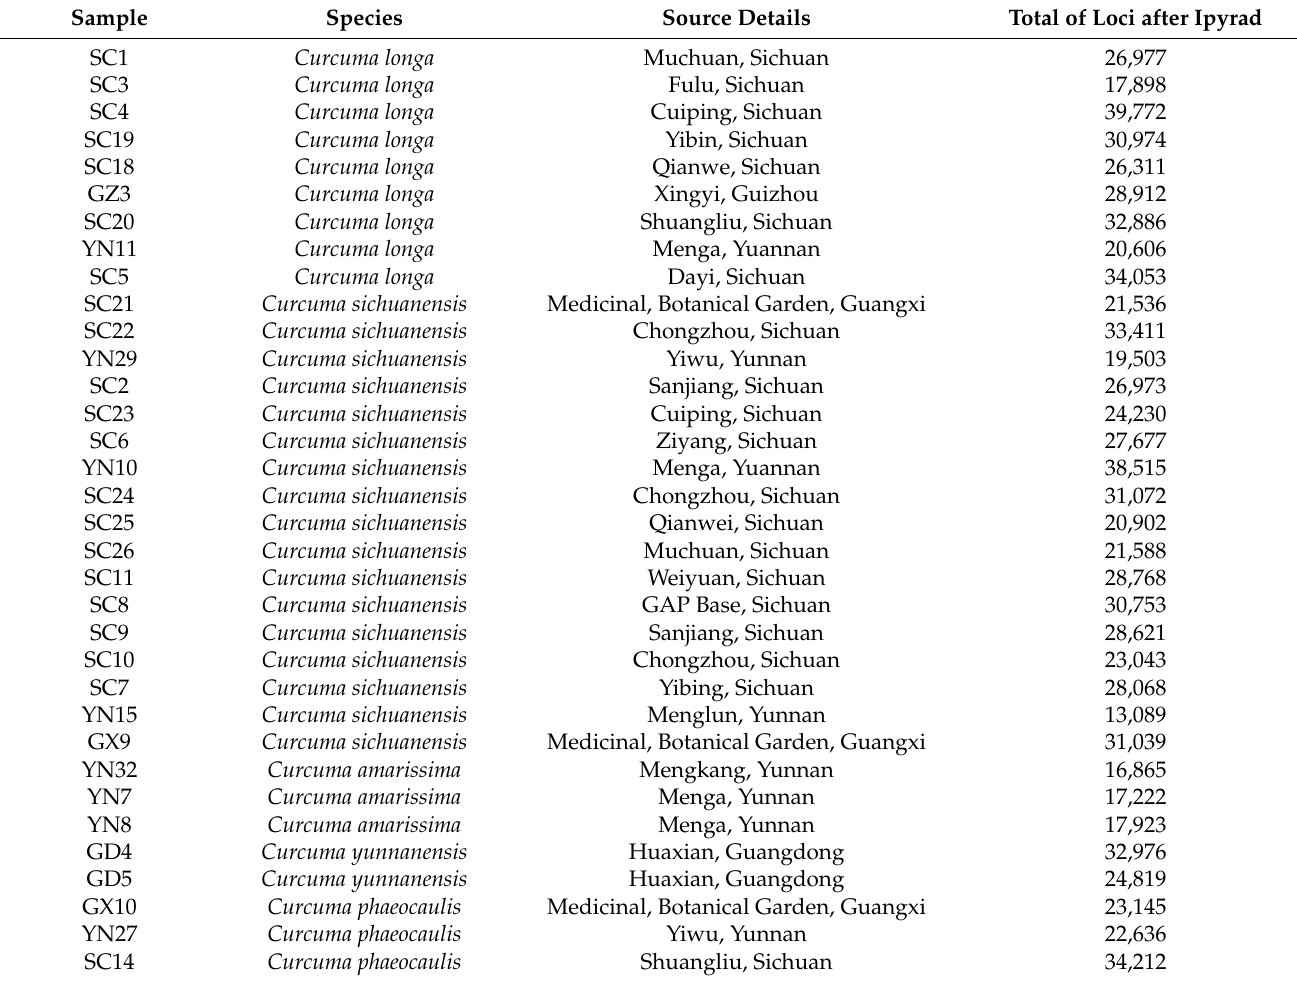
Table 1. Sample of species, with source details and total loci after processing with ipyRAD, of the 61 individuals used in phylogenetic analyses. Each sample has a sample name, species name, collecting information, and loci information. Sample Species Source Details Total of Loci after